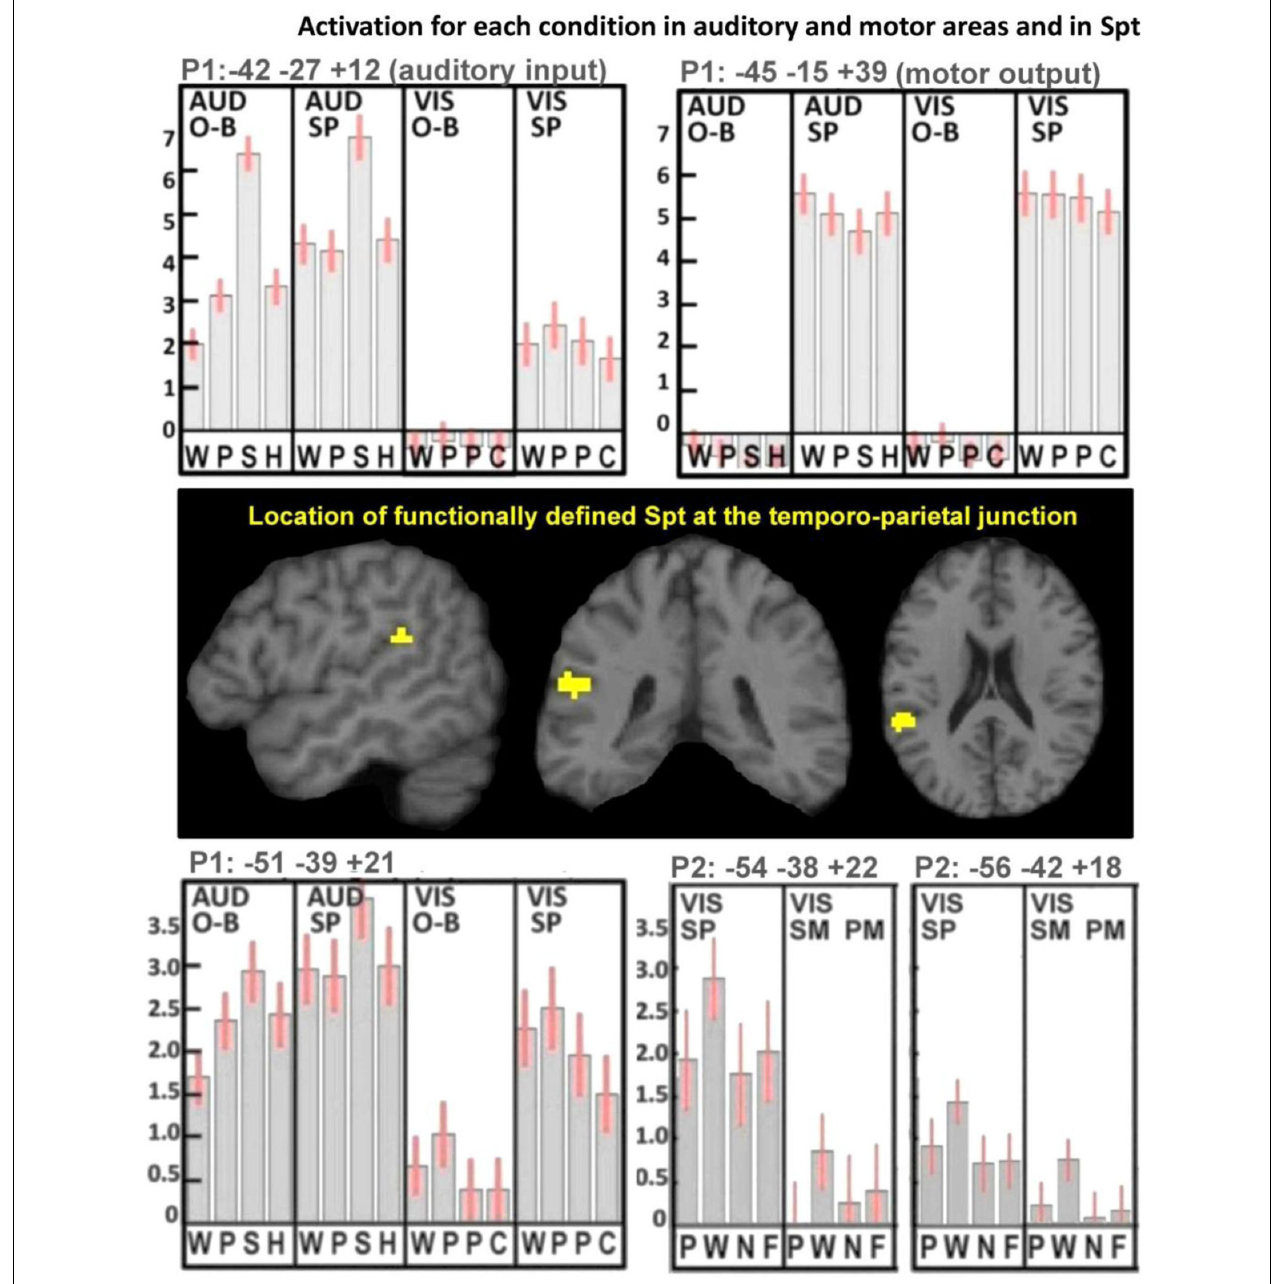
FIGURE 3 |Activation for each condition in auditory and motor areas, and in Spt. These results illustrate the mean activation responses across all conditions in primary auditory and motor areas as well as in Spt. The top plots show activation responses for one-back (O-B) and speech production (SP) tasks in both auditory (AUD) and visual (VIS) modalities in left Heschl’s gyrus (top-left plot, labeled “auditory input”) and left central sulcus (top-right plot, labeled “motor output”). In the AUD modality, the stimuli were words, pseudowords, environmental sounds, and humming (WPSH). In the VIS modality, the stimuli were words, pseudowords, pictures of objects, and pictures of scrambled objects (WPPC). The center images locate our functionally defined mask for Spt at the TPJ. The bottom plots show activation responses in Spt in Paradigm 1 (P1; bottom-left plot) and in Paradigm 2